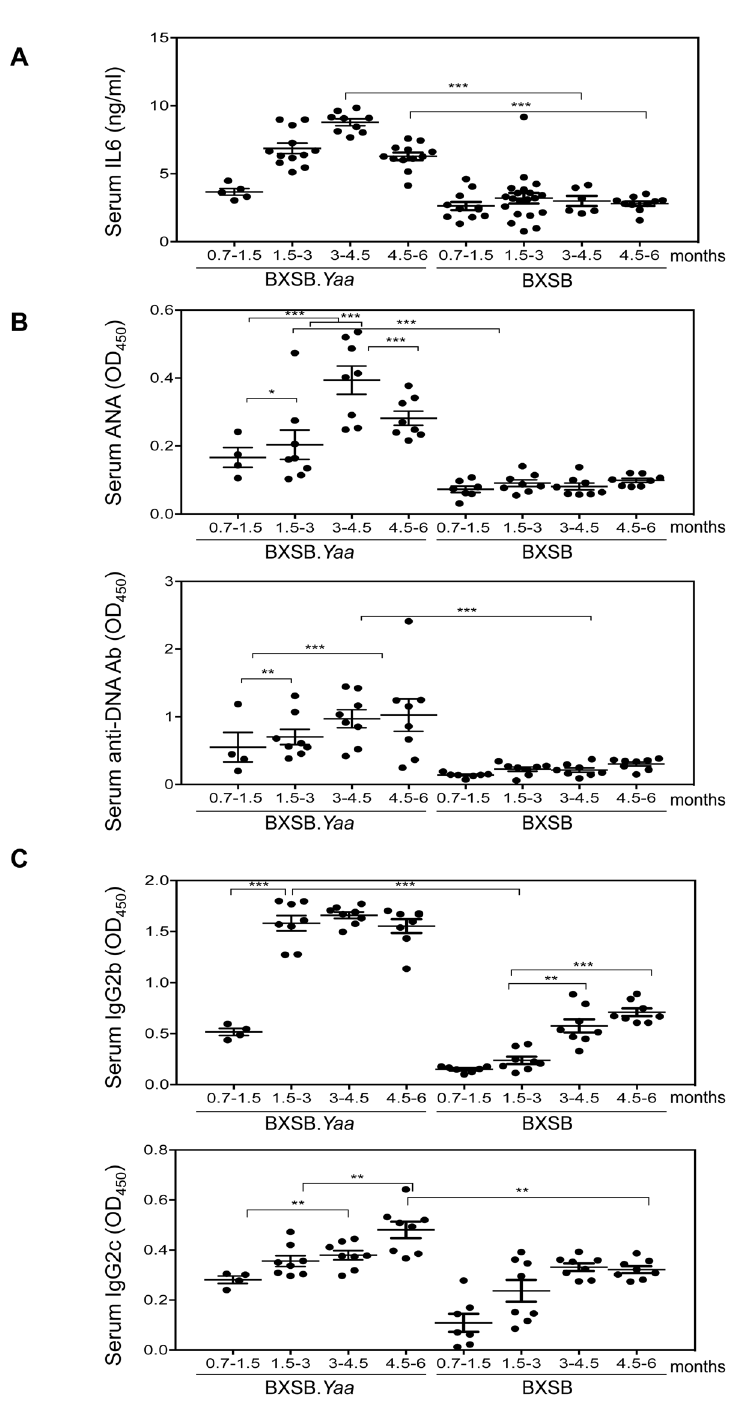
Fig 1. IL6 levels correlate with disease manifestations in BXSB. Yaa mice. Sera from BXSB. Yaa and BXSB mice of different ages were collected and tested for the levels of (A) IL6 (B) anti-nuclear antibodies (ANA) and anti-dsDNA antibodies, and (C) immunoglobulin isotypes (IgG2b and IgG2c); n = 4 – 20 mice per age group. Each dot represents one mouse. Horizontal bars represent mean ± SEM. p values are calculated by one-way ANOVA with Tukey ’ s multiple comparison tests. * p < 0.05, ** p < 0.01, *** p < 0.0001.